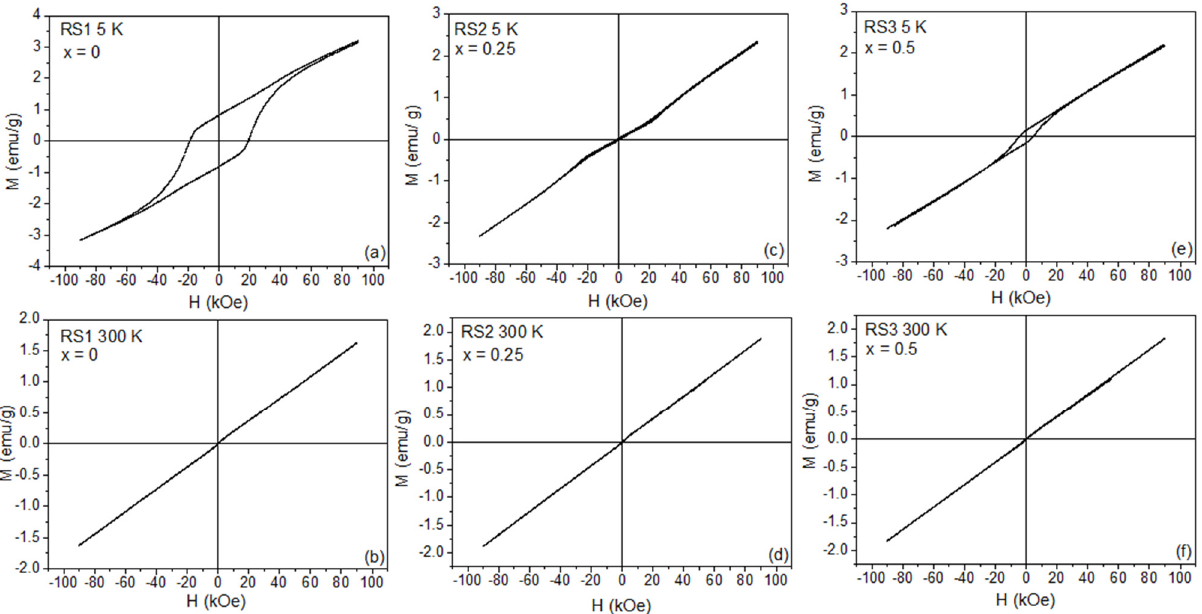
Figure 3. M(H) curves recorded for a maximum field of 90 kOe at 5 K (top) and 300 K (bottom) for the RSX samples. RS1 in ( a ) and ( b ), RS2 in ( c ) and ( d ), and RS3 in ( e ) and ( f ), respectively.